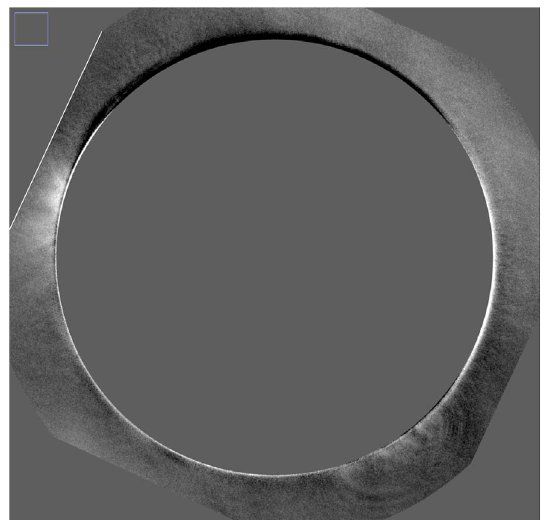
Fig. 9. Image from C2 with FeXIII fi lter on 17 September 2017 at 10:57 UTC. Magnetic fi eld lines are visible almost all around the solar disk (magnetic loops on the top left and bottom right for